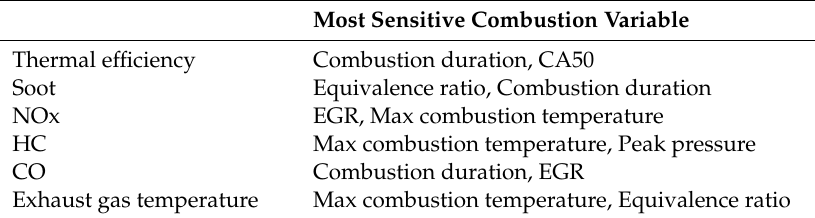
Table 2. Major physical properties of diesel.